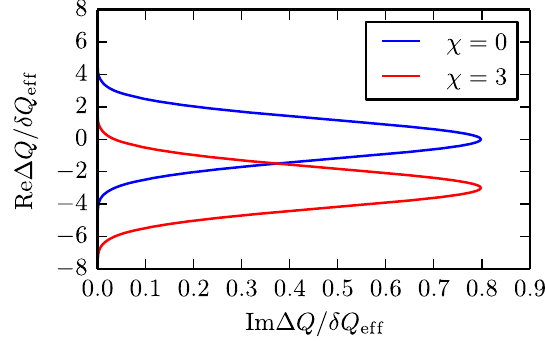
FIG. 4. Stability diagram with and without space charge from Eq. (10).